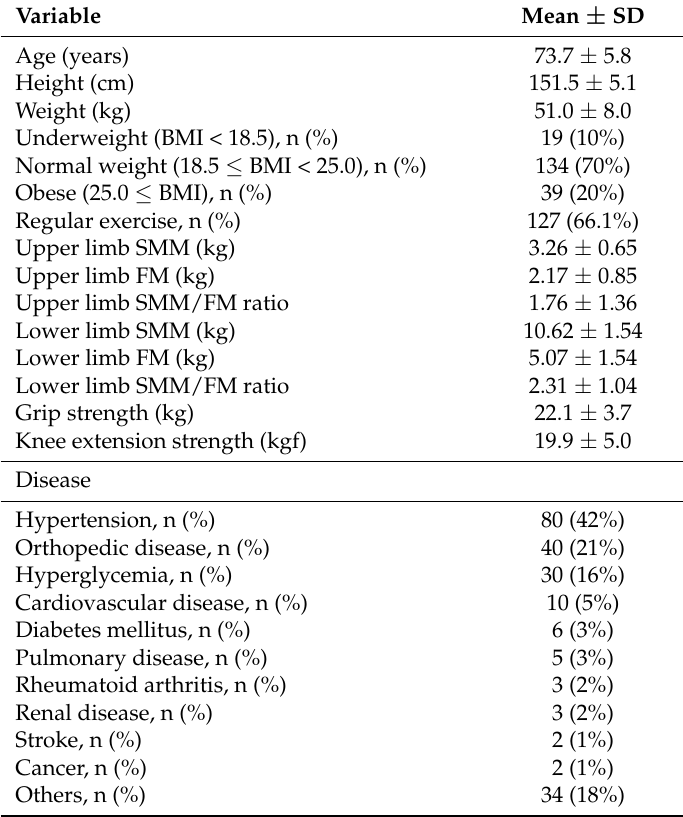
Table 1. Participant